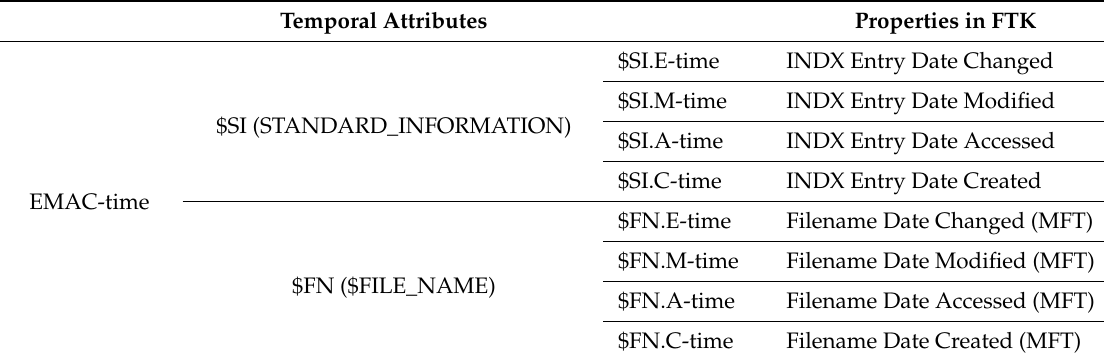
Table 1. Timestamp